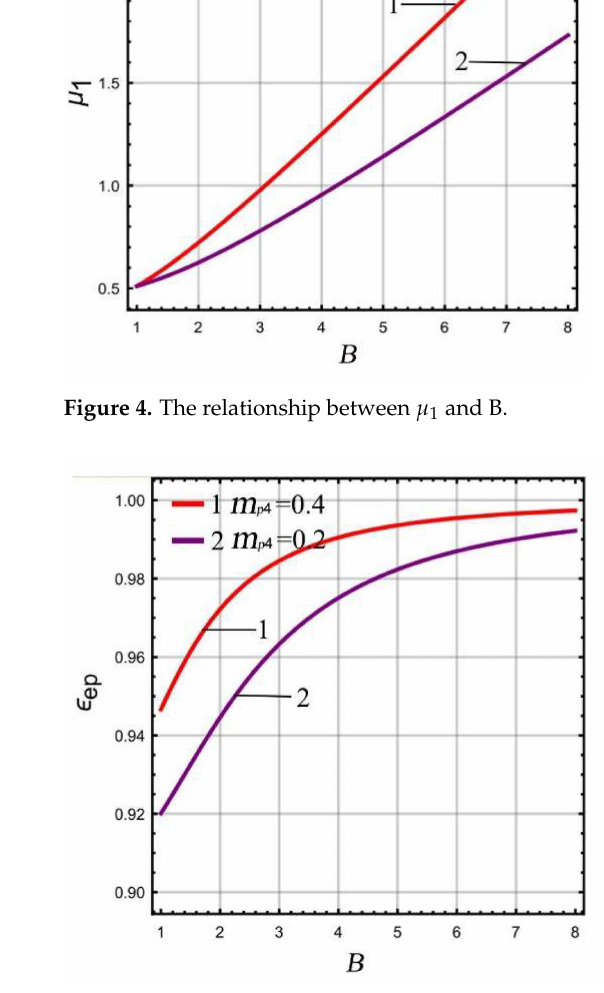
Figure 5. The relationship between (cid:101) ep and